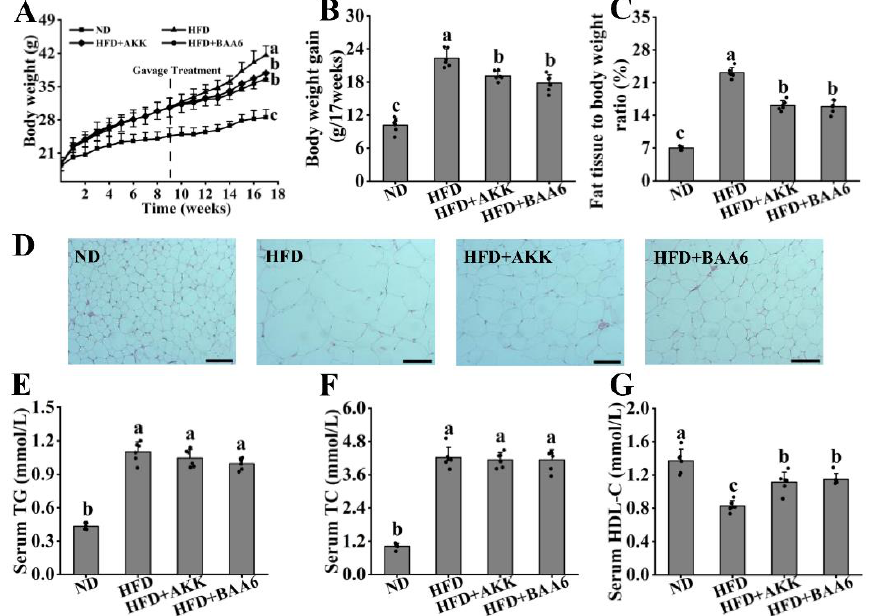
Figure 1. Effect of BAA6 administration on metabolic characteristics in high-fat diet (HFD)-fed mice. ( A ) Body weight, ( B ) body weight gain, ( C ) relative adipose tissue, ( D ) representative hematoxylin and eosin staining in epididymal adipose tissues (scale bar, 200 µ m), serum levels of ( E ) triglyceride (TG), ( F ) total cholesterol (TC), and ( G ) high-density lipoprotein cholesterol (HDL-C) were analyzed. Values are shown as means ± SD ( n = 6). Different lowercase letters mean remarkable differences between groups at p < 0.05. ND, fed normal diet; HFD, fed high-fat diet; HFD + BAA6, fed high-fat diet and administrated with Bifidobacterium animalis subsp. lactis A6 (BAA6); HFD + AKK, fed high-fat diet and administrated with Akkermansia muciniphila